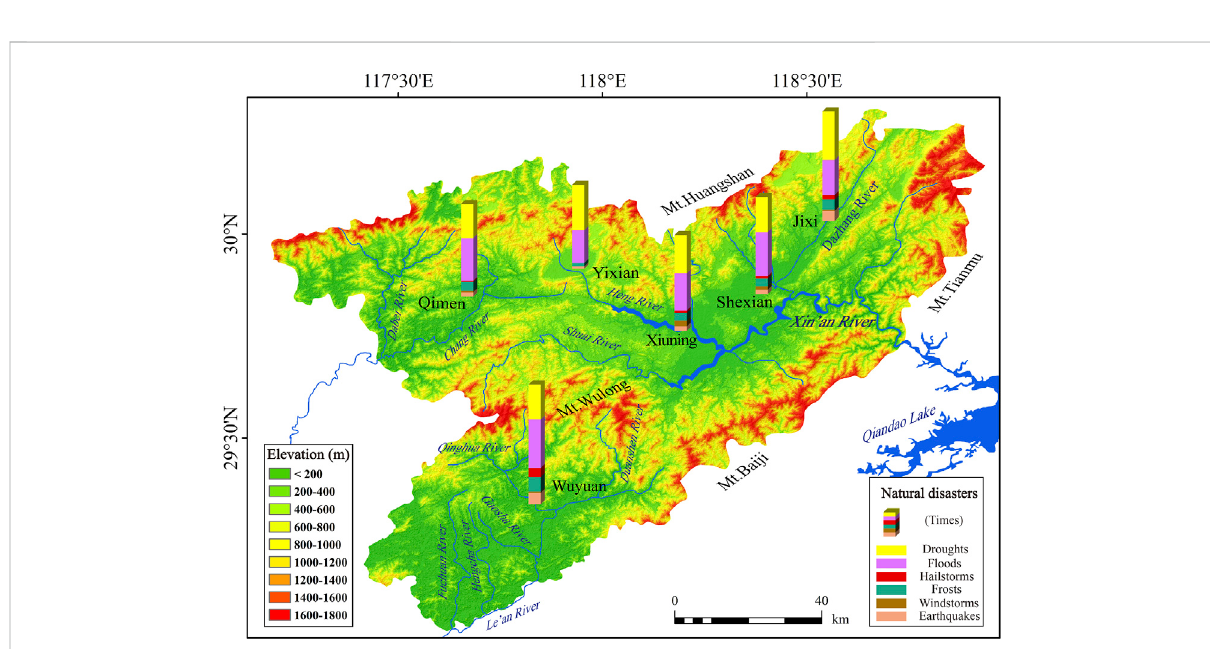
FIGURE 5 Spatial distributions of the various natural disasters in Huizhou during the Ming and Qing